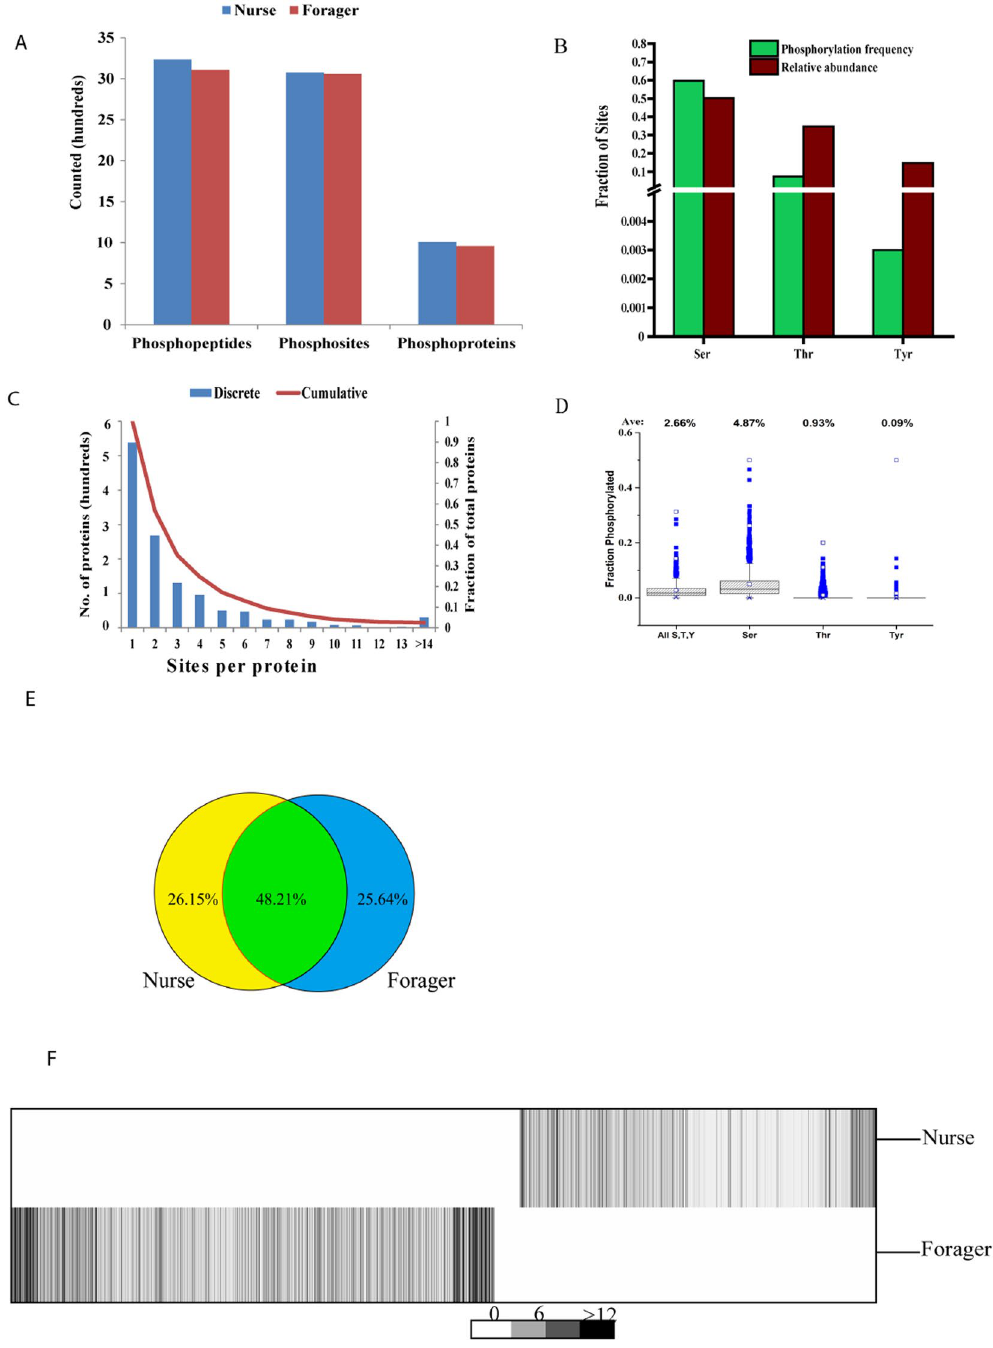
Figure 1. Overview of age-specific phosphorylation in the brain of honeybee ( A. m. ligustica ). ( A ) Number of phosphopeptides, phosphosites and phosphoproteins detected at distinct ages of the honeybee brain. ( B ) Relative frequencies of Ser, Thr, and Tyr within all phosphoproteins and their relative likelihood of phosphorylation. The relative abundances found in the data indicate the relative number of Ser, Thr, or Tyr (total-phosphorylation and non-phosphorylation) found in the data. ( C ) Histogram depicting numbers of sites observed per protein. ( D ) Box plots indicating the relative extents of modification for residues prone to phosphorylation within all observed phosphoproteins. ( E ) Pie chart indicating numbers of phosphosites detected in the nurse and forager honeybees. ( F ) Hierarchical clustering of phosphosites and different ages of the honeybee brain based on number of spectral counts. The two ages were compared and the sums of the average spectral count were 32,152 and 22,751for forager and nurse honeybees,